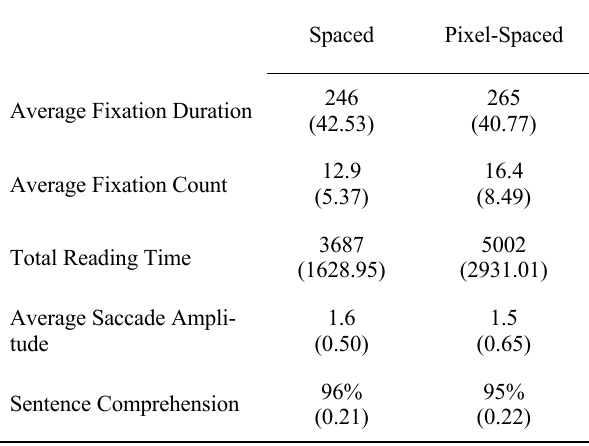
Table 1. Descriptive Statistics for the Dependent Measures in Experiment 1.